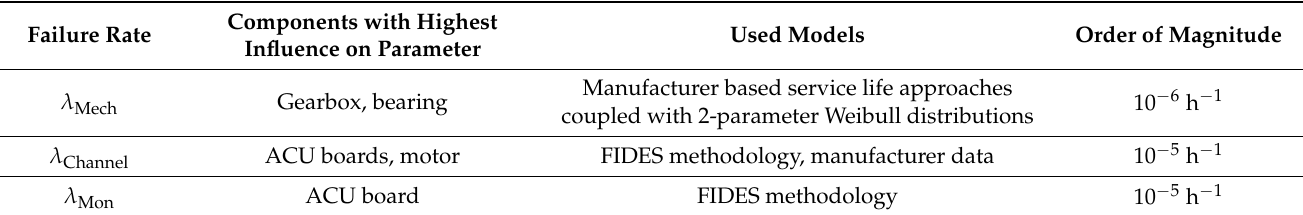
Table 2. Holistic approach for the component failure